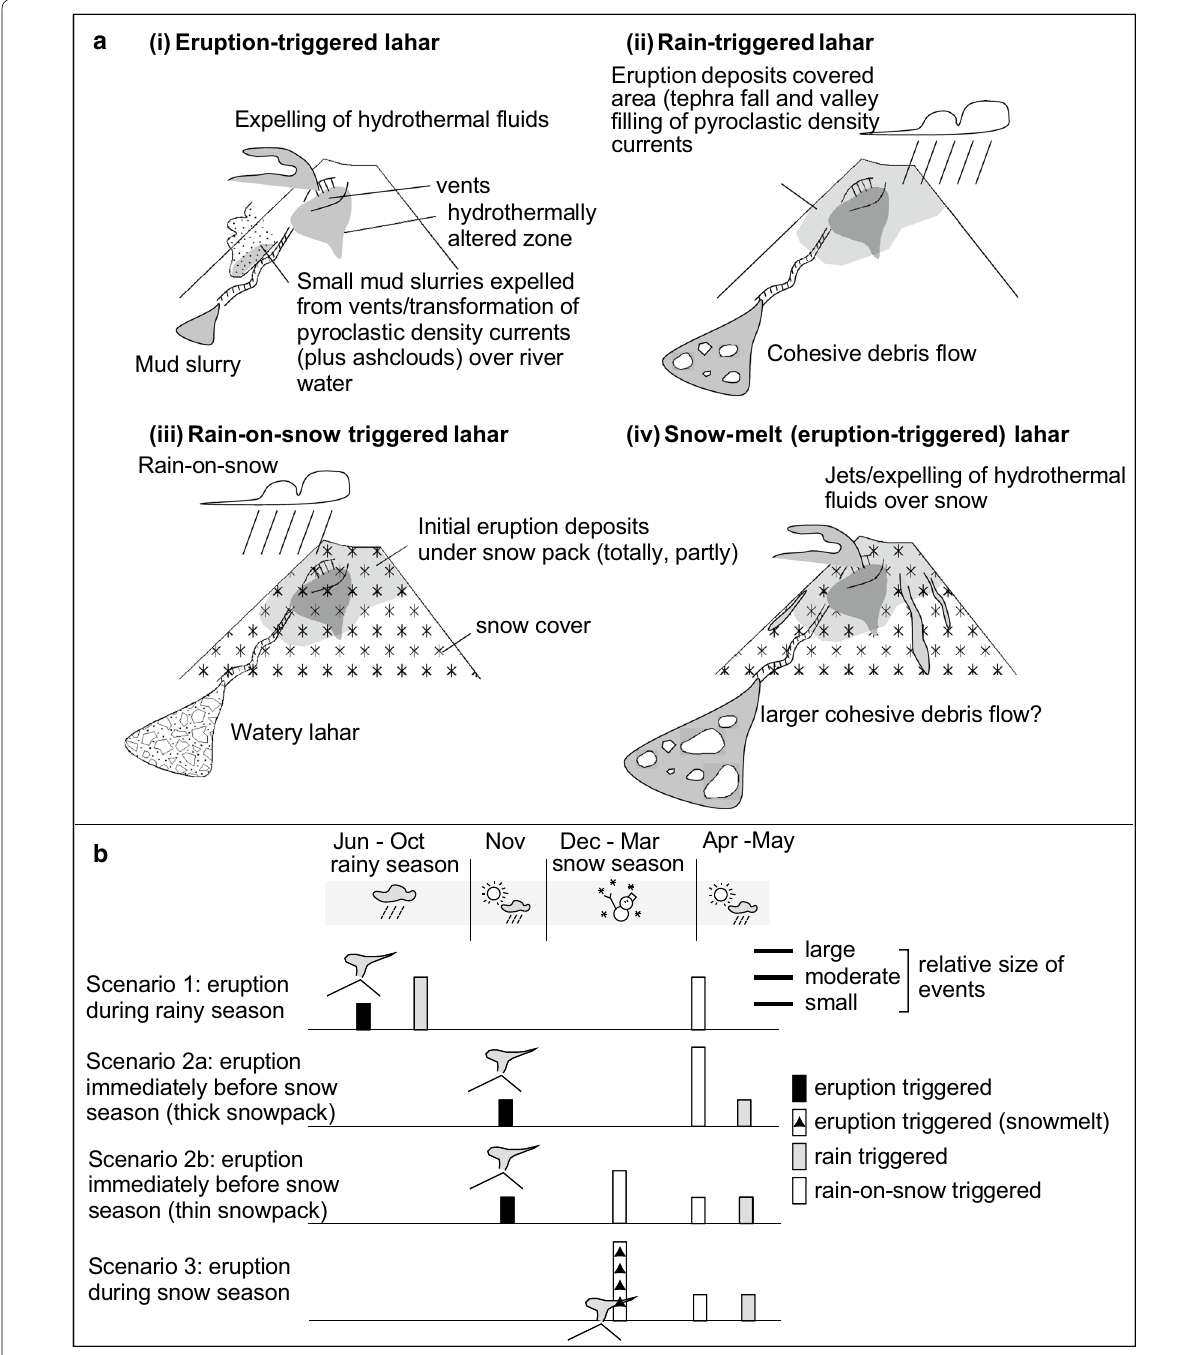
Fig. 11 Schematic models showing a observed (i to iii) and possible (iv) lahar events for syn-eruptive and post-eruptive periods at Ontake Volcano and b observed Scenario 1 and predicted Scenarios 2a, 2b and 3 of lahar events of the volcano when a similar scale of 2014 phreatic eruption